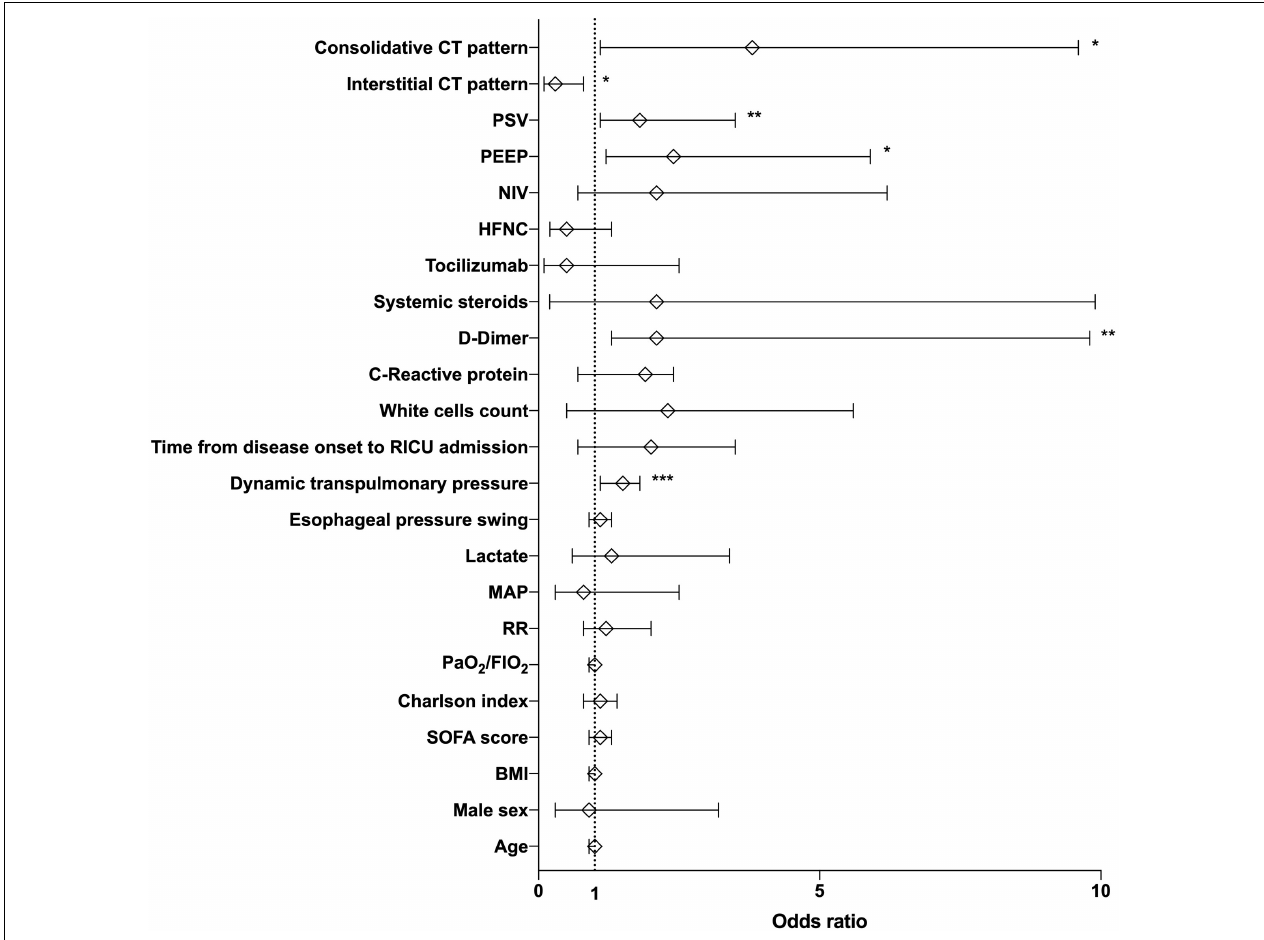
FIGURE 2 | Risk factors for air leak onset while on spontaneous breathing during COVID-19 acute respiratory failure. Multiple logistic regression analysis showing the association between clinical, physiological, and radiological variables with the occurrence of pneumothorax and pneumomediastinum in the study cohort by means of odds ratios (open diamonds) and relative 95% confidence intervals (error bars). * p = 0.04, ** p = 0.03, and *** p = 0.01. Significance was set for p < 0.05. CT, computed tomography; PSV, pressure support; PEEP, positive end-expiratory pressure; NIV, non-invasive ventilation; HFNC, high-flow nasal cannula; RICU, respiratory intensive care unit; MAP, mean arterial pressure; RR, respiratory rate; SOFA sequential organ failure assessment; BMI, body mass